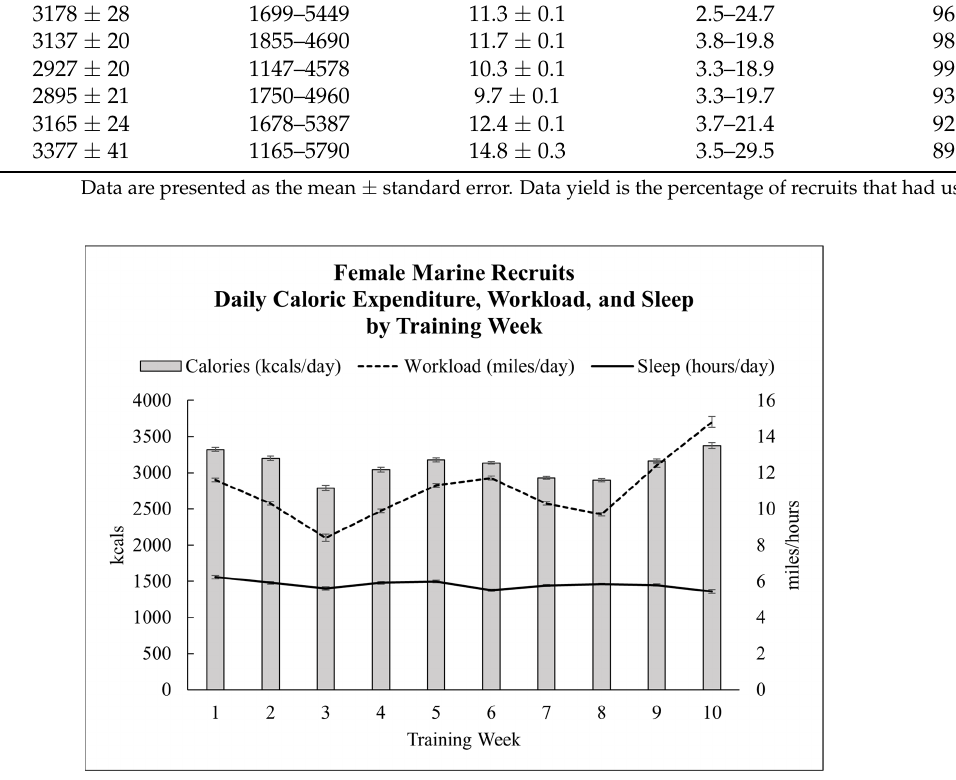
Figure 1. Daily workload, caloric expenditure, and sleep duration by training week.